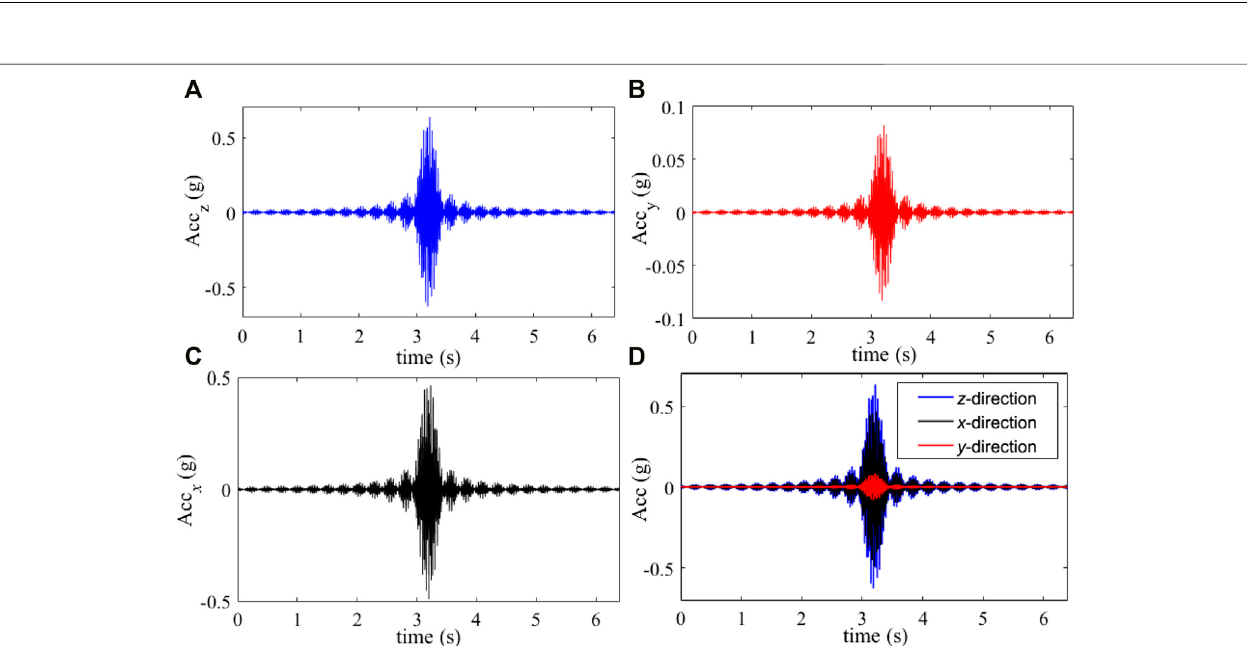
FIGURE 9 | The time histories of the displacement response at the